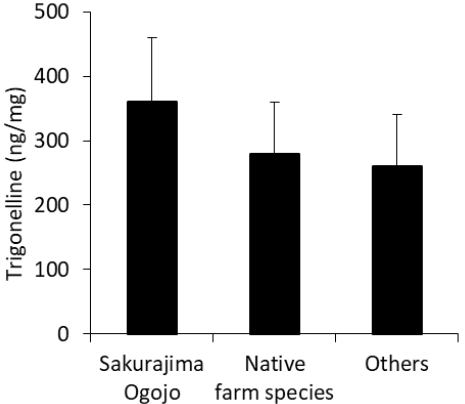
Figure 2. Differences in trigonelline contents among Sakurajima radish varieties. ‘Sakurajima Ogojo’ are an F1 variety with lower occurrence of hollow cavity and pores. ‘Native farm species’ are the largest varieties and have been inherited for many years. ‘Others’ which represented a mixture that do not classified other varieties. All values are represented as means ± SD. There were no significant di ff erences observed between these varieties.